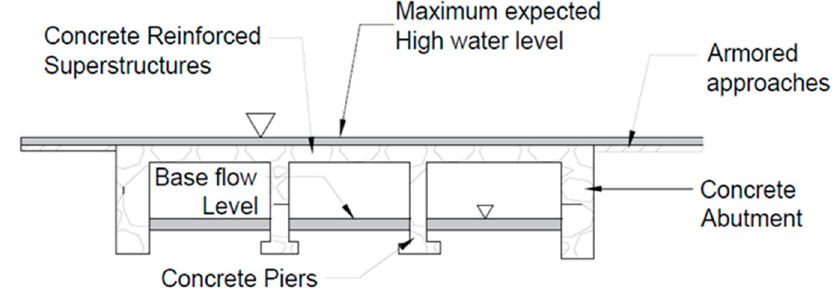
Figure 3. Schematic of a Low-Water Bridge.